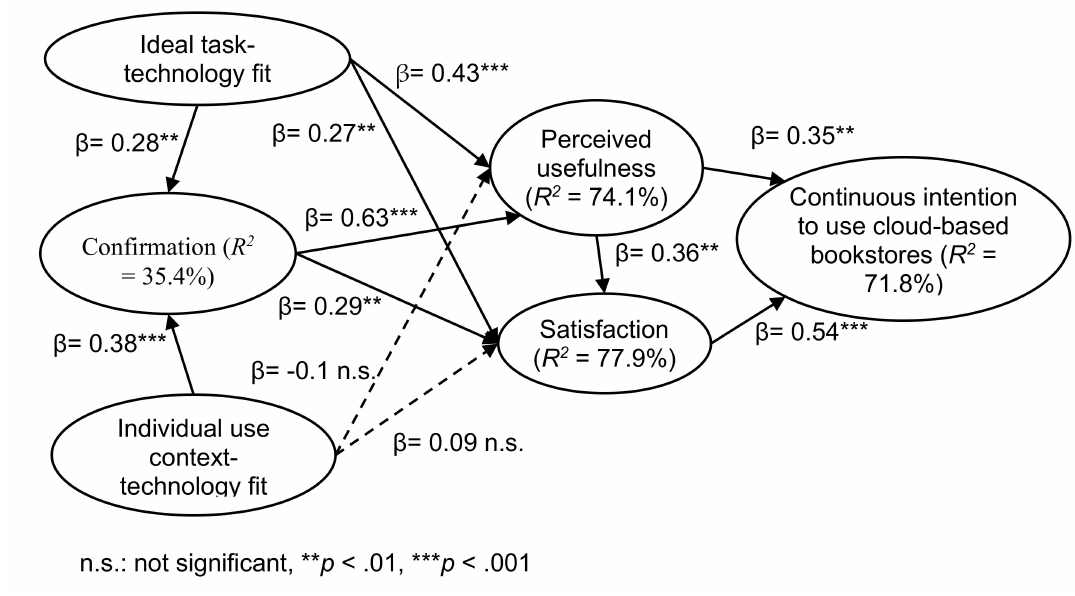
Figure 5. Structural model